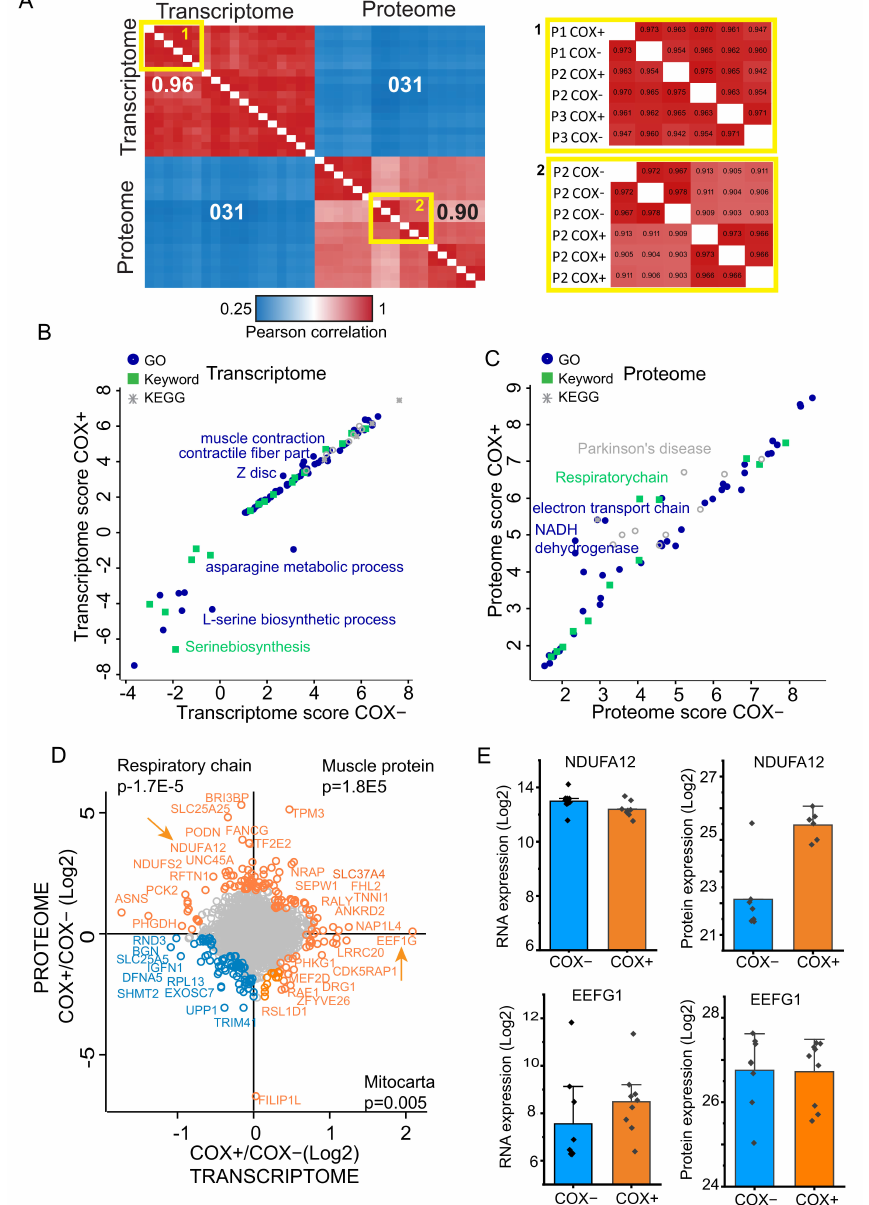
Figure 4. Integration of dataset and multi-omics analysis of common gene products. ( A ) Multi-scatter plot-based heatmap of Pearson correlations among all transcriptome and proteome single run. n = 9 patients for transcriptome. n = 3 patients for proteome. Pearson correlation color scale is displayed at bottom. Insets on the right show enlarged areas of the main heatmap (areas with yellow